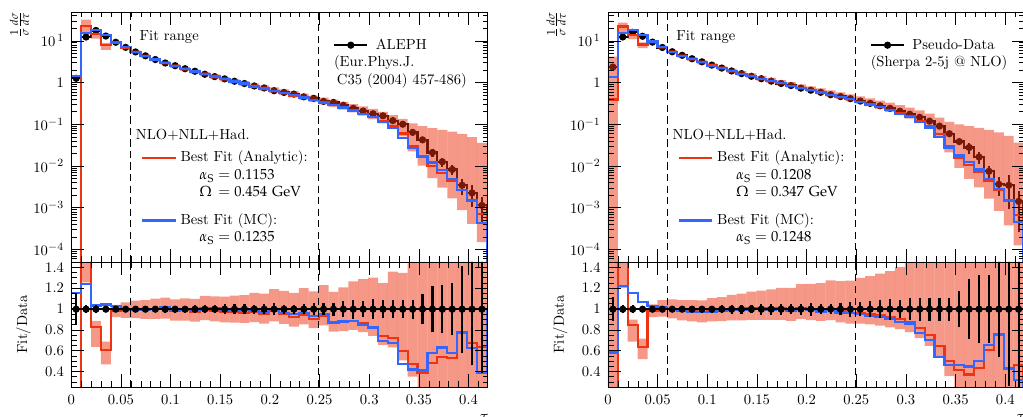
Figure 7. Plain thrust distribution as measured by ALEPH (left) and for Monte Carlo pseudo data ( Sherpa MEPS@NLO 2-5j, right) compared to the NLO+NLL prediction with the best-(cid:12)t values for (cid:11) s ( m Z ) and the analytic (red) and Monte-Carlo (blue) hadronisation corrections. Uncertainties of the pseudo data are determined by rescaling of the uncertainties for the plain-thrust ALEPH